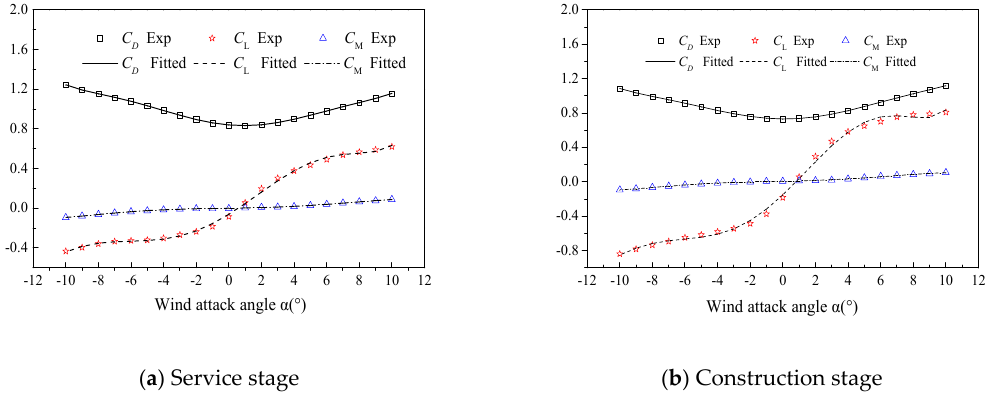
Figure 7. Wind force coefficients at wind attack angles of − 10°~+10° (‘Exp’ for experimental value; ‘Fitted’ for fitted value). Table 2. Aerodynamic force coefficients and derivatives for the service stage.